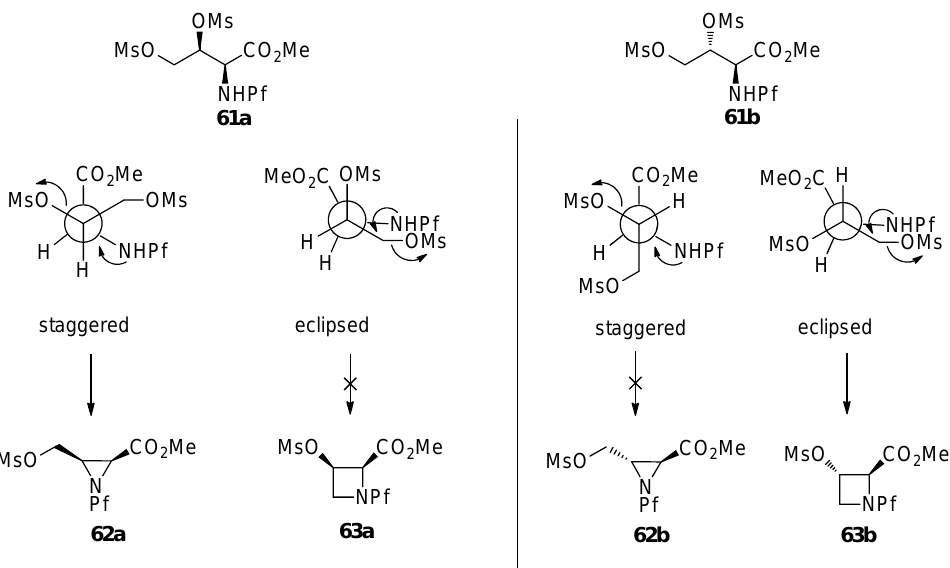
Figure 8. Newman-projections that explain the differences in